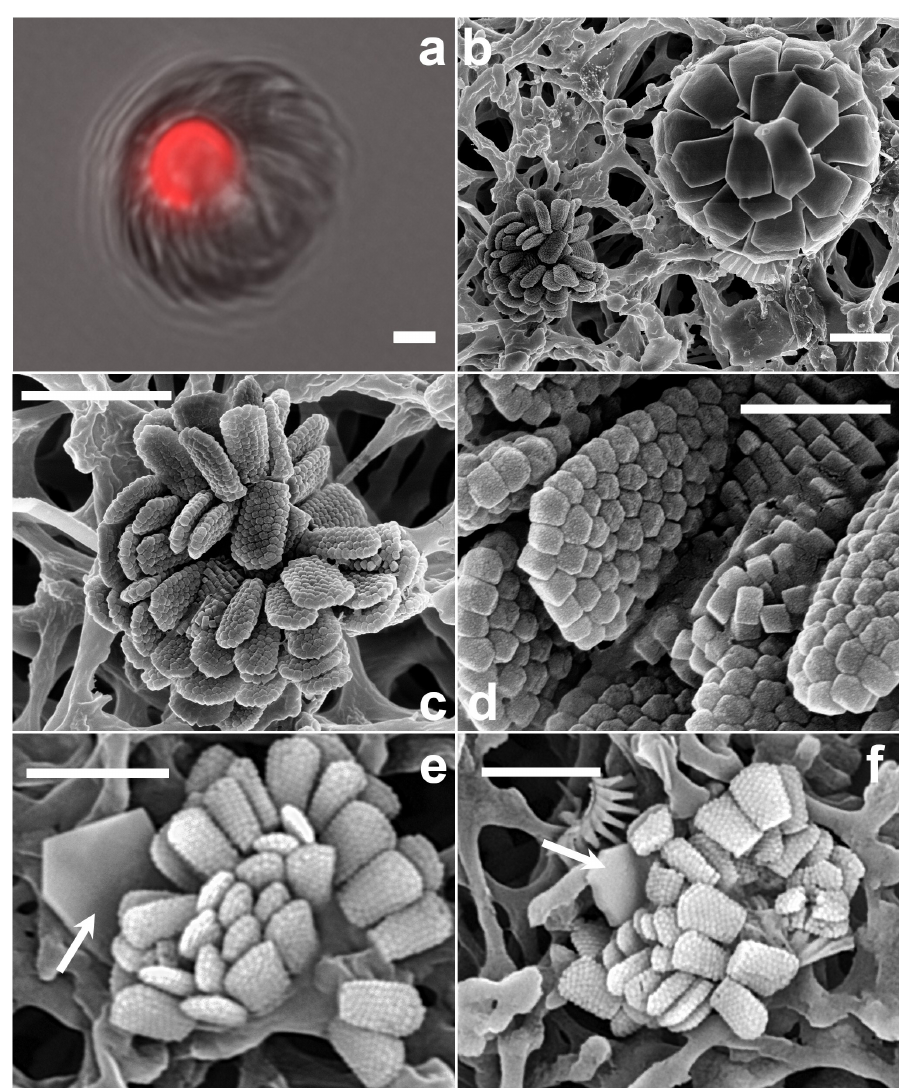
Figure 12. Florisphaera profunda . (a) Phase-contrast and epifluorescence micrograph images taken from fresh a Florisphaera cell depict- ing the chloroplast auto-fluorescence in red (490 / 630nm, excitation / emission). Fluorescent chloroplast in a coccosphere (GoA, 17 Au- gust 2020, 120m). (b) HET (right) and putative HOL (left) in close vicinity on the filter. (c) Coccosphere and (d) close-up of coccoliths of Holococcolithophore sp. cf. F. profunda ( b–d from GoA, 11 September 2017, 120m). (e, f) Holococcolithophore coccospheres with nan- noliths of two different variants of F. profunda (arrows) (GoA, 17 August and 11 September 2017, 120m). Scale bars: 2µm, close-up of coccoliths at